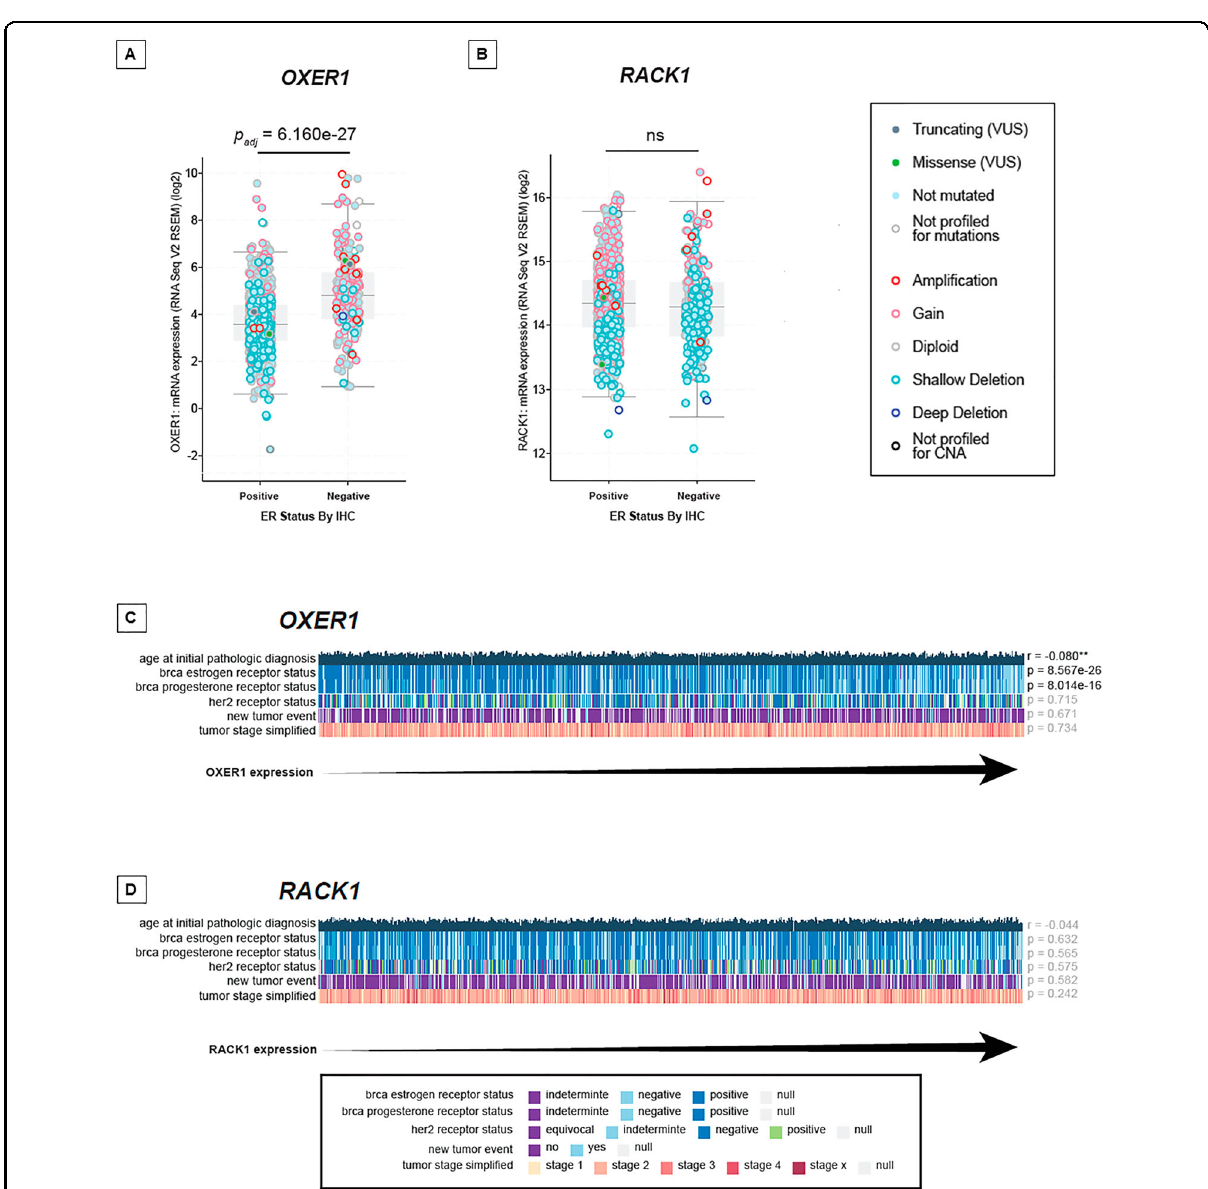
Fig. 6 OXER1 mRNA expression in breast cancer subtypes. A – B Normalized expressions values for OXER1 (left) and RACK1 (right) were retrieved from TCGA (Firehose database) using cBioportal,and strati fi ed according to Estrogen-receptor status. Provided is a legend with annotations respective to copy number and mutational status of the indicated genes. Statistical signi fi cance was assessed using Wilcoxon sum-rank test and adjusted for multiple comparison using Bonferroni correction. C – D Provided are clinical features (Age at diagnosis, Tumor stage, new tumor event, ER/PR/ Her2 status) and their association to increasing expression levels of either OXER1 (top) or RACK1 (bottom) mRNAs. A detailed legend is provided at the bottom. Data were retrieved from TCGA using Mexpress portal